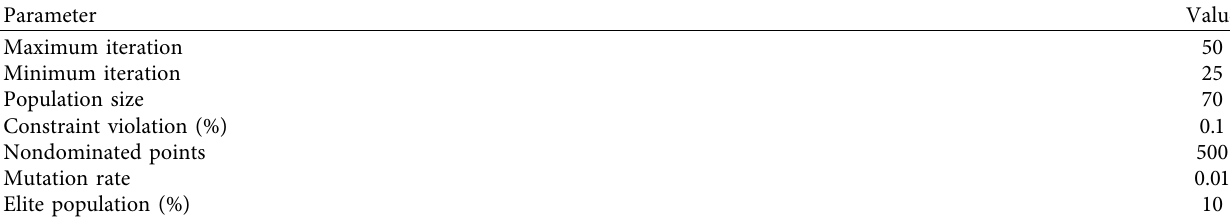
Table 3: Parameter definitions of the